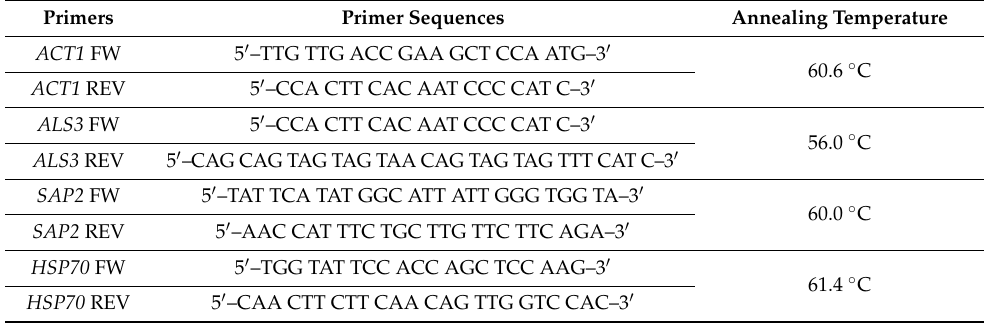
Table 3. Primer sequence conditions for